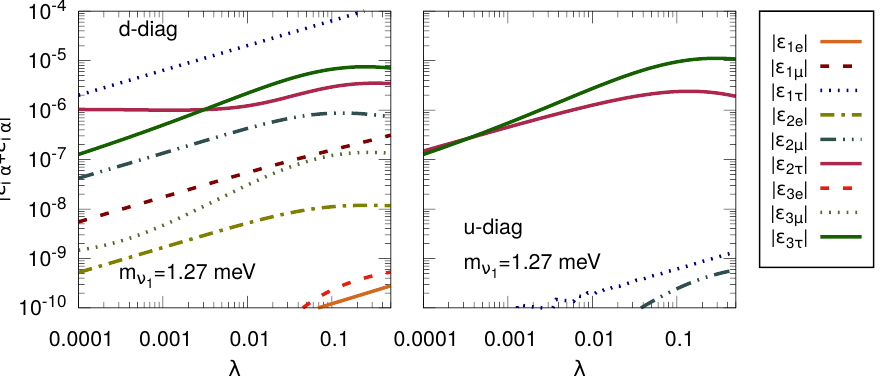
Figure 10 . Washout factor vs. quartic coupling in the hierarchical spectrum scenario of RH (cid:23) . The left (right) panel corresponds to the d ( u )-quark diagonal basis. The lightest neutrino mass is kept at m (cid:23) = 0 : 00127 eV. Other parameters are kept (cid:12)xed as described in the text. 1